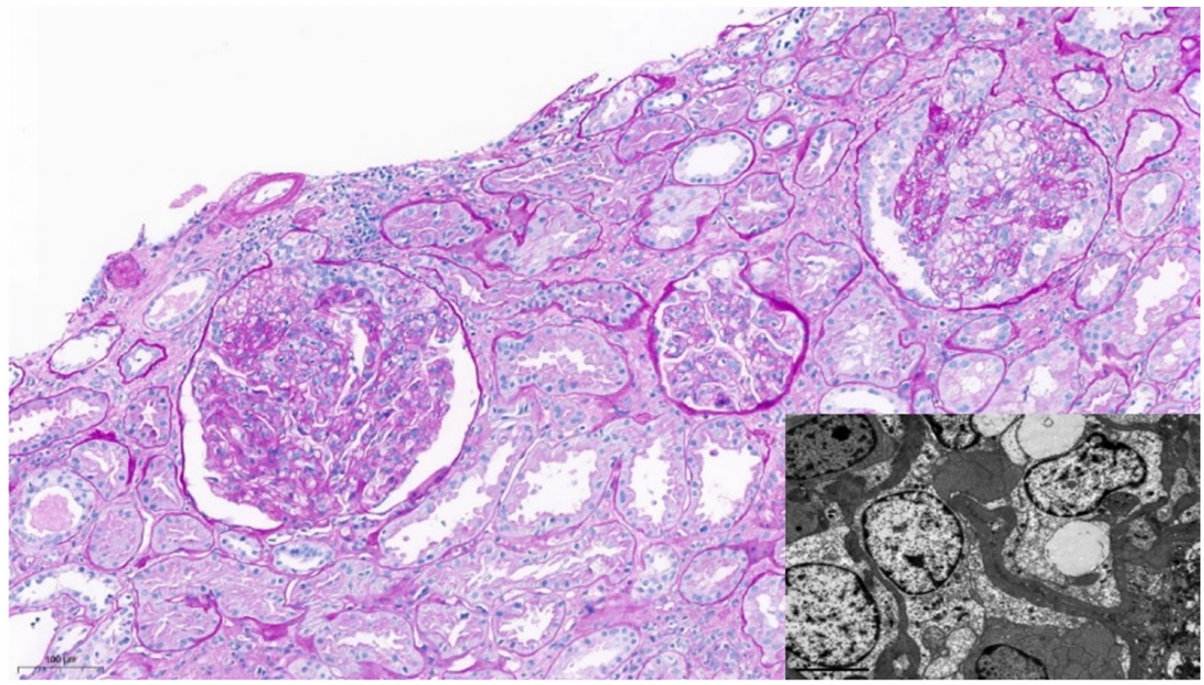
Figure 1. Periodic acid–Schiff stain x13: Endocapillary hypercellularity with epithelial hypertrophy in two glomeruli and segmental foam cells infiltration ( top right ). Basement membrane collapse. No necrotizing lesions were present. The interstitium shows mild focal infiltrates predominantly consisting of lymphocytes and plasma cells. No tubulitis, capillaritis or endothelialitis are present. The degree of interstitial fibrosis and tubular atrophy is mild. Electron microscopy: Extensive foot process effacement and segmental hypertrophied podocytes ( lower left ). Although some of the findings are consistent with the cellular variant, this image is, according to the Columbia classification, a Collapsing